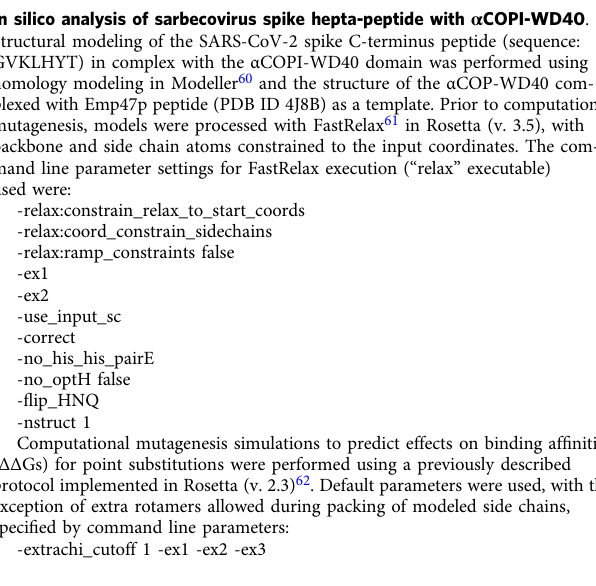
Reporting summary . Further information on research design is available in the Nature Research Reporting Summary linked to this article. Data availability Coordinates for the crystal structures have been deposited in the Protein Data Bank with IDs: 7S22 (wild-type), 7S16 (Arg 57 → Ala), and 7S23 (Tyr 139 → Ala). The plasmids for constructs pSUMO- β ′ -COPI-WD40, pcDNA3.1( + )- α COPI-WD40, pcDNA3.1( + )- α COPI- WD40 mutant Arg 57 → Ala, pcDNA3.1( + )- α COPI-WD40 mutant Asp 115 → Ala,